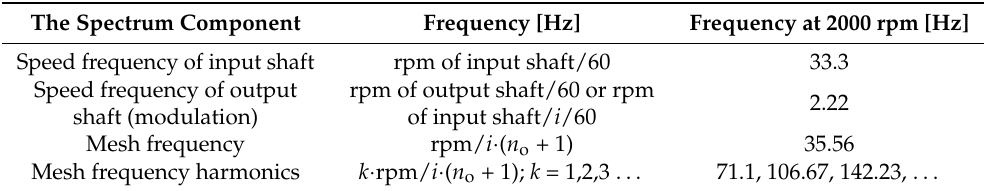
Table 1. The main frequency components of the spectrum of the torque fluctuations and vibra- tions signals.